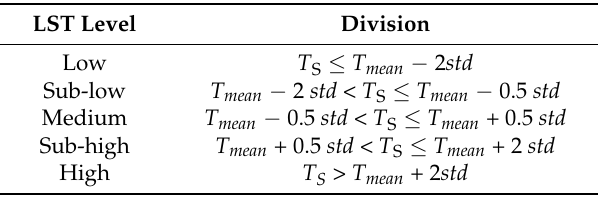
Table 2. Ranking of land surface temperature (LST)